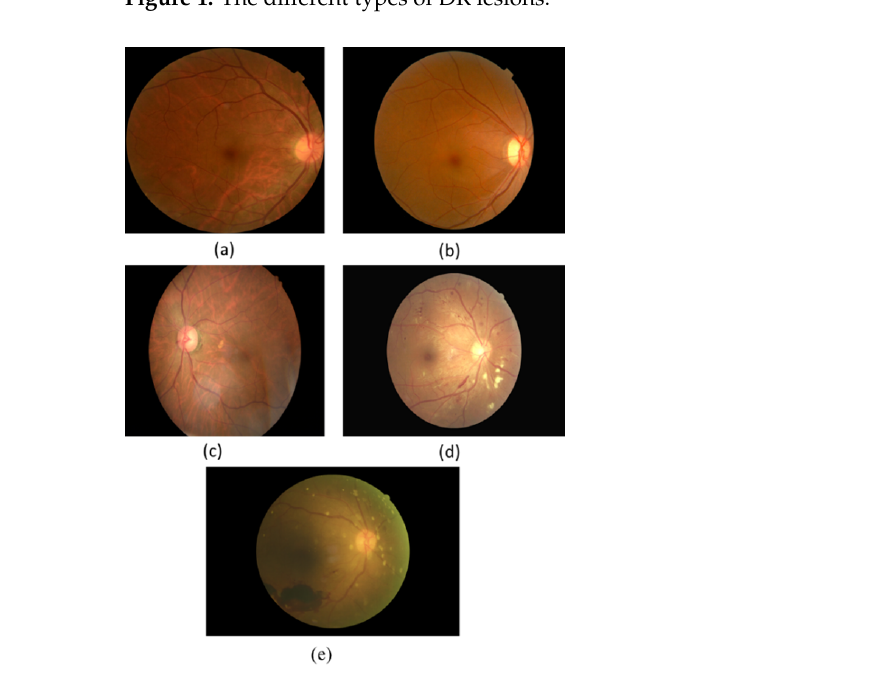
Figure 2. The DR stages: ( a ) No DR ( b ) Mild, ( c ) Moderate, ( d ) Severe, ( e ) Proliferative DR. Table 1. The DR stages depending on lesions classification